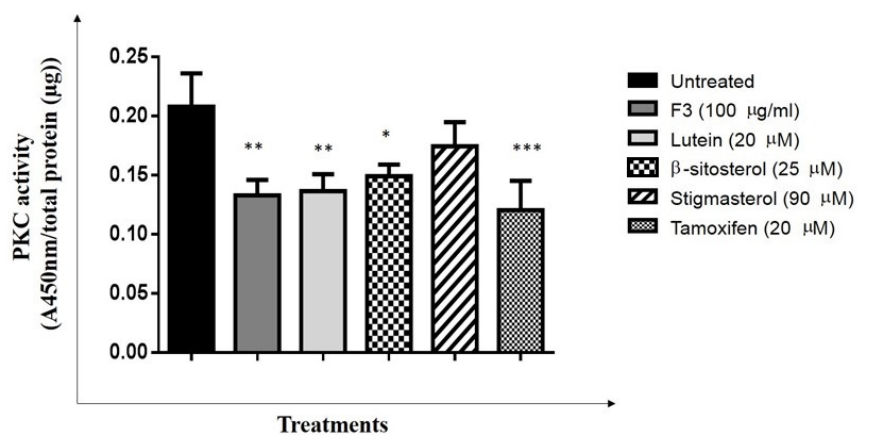
Figure 4. PKC activity. MDA-MB-231 cells were treated with IC 50 concentrations of F3, lutein, β -sitosterol, and stigmasterol for 24 h. The PKC activity in treated cells was measured using a spectrophotometer. Data are presented as the mean ± SD ( n = 3). * p < 0.05; ** p < 0.01; *** p < 0.001